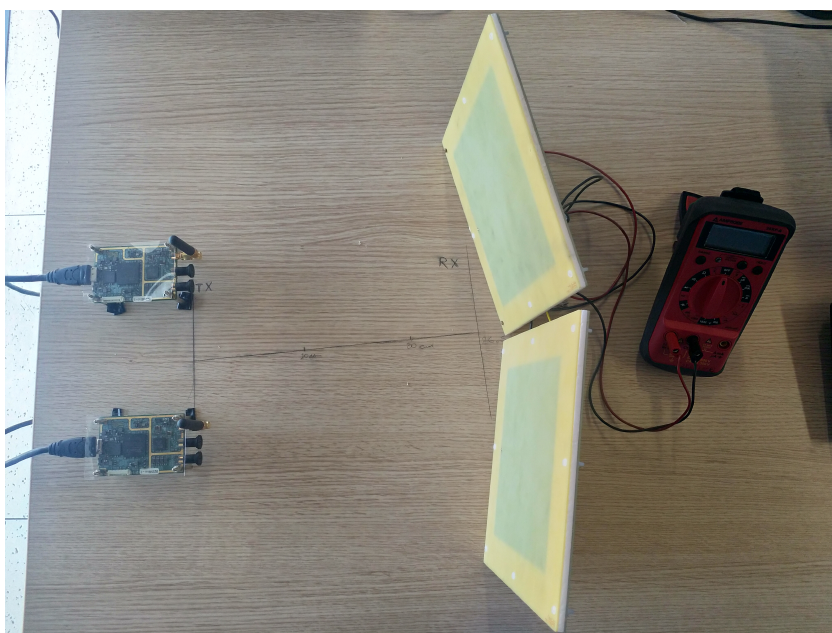
Figure 8. Illustration of the testbed; two Software Defined Radio (SDR) transceivers are used as CW transmitters (left side), and two rectennas (right side) that implement the WPT rectifier.